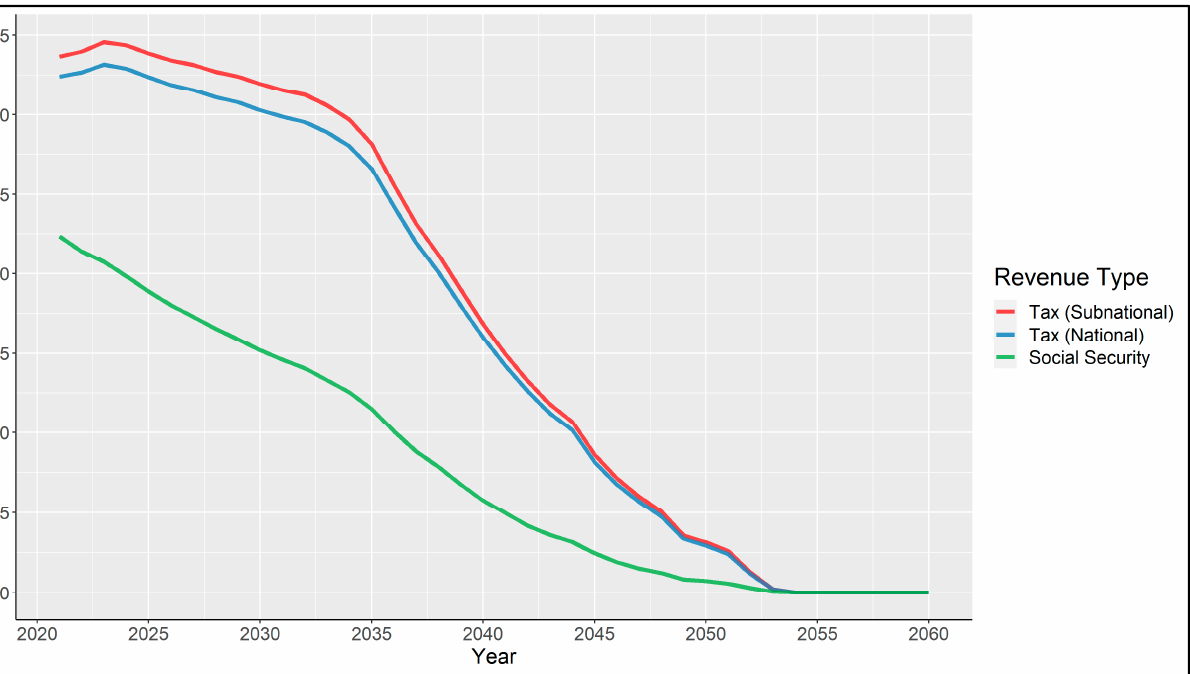
Figure 5. Breakdown of tax (national and subnational) and social security revenues, 2021–2060, B scenario.